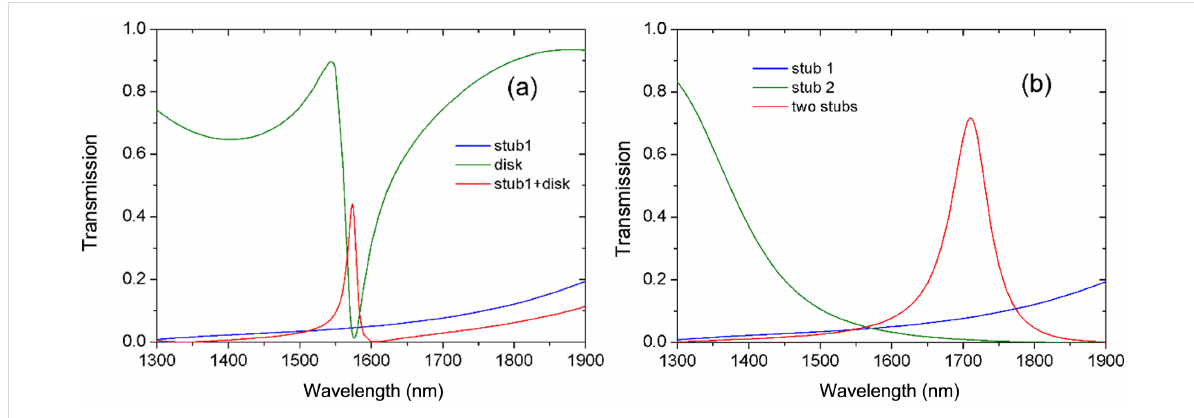
Figure 2: Transmission spectra for different resonator-coupled structures. The radius of the disk is R = 280 nm. The lengths of the stubs are L